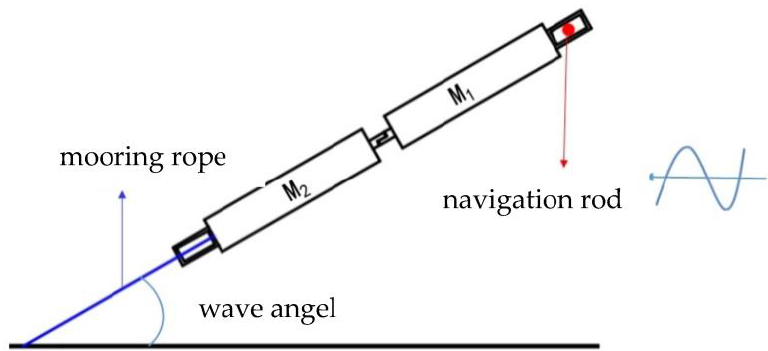
Figure 4. Mooring scheme under a head wave. Figure 5. Mooring scheme under an oblique Figure 5. Mooring scheme under an oblique wave.